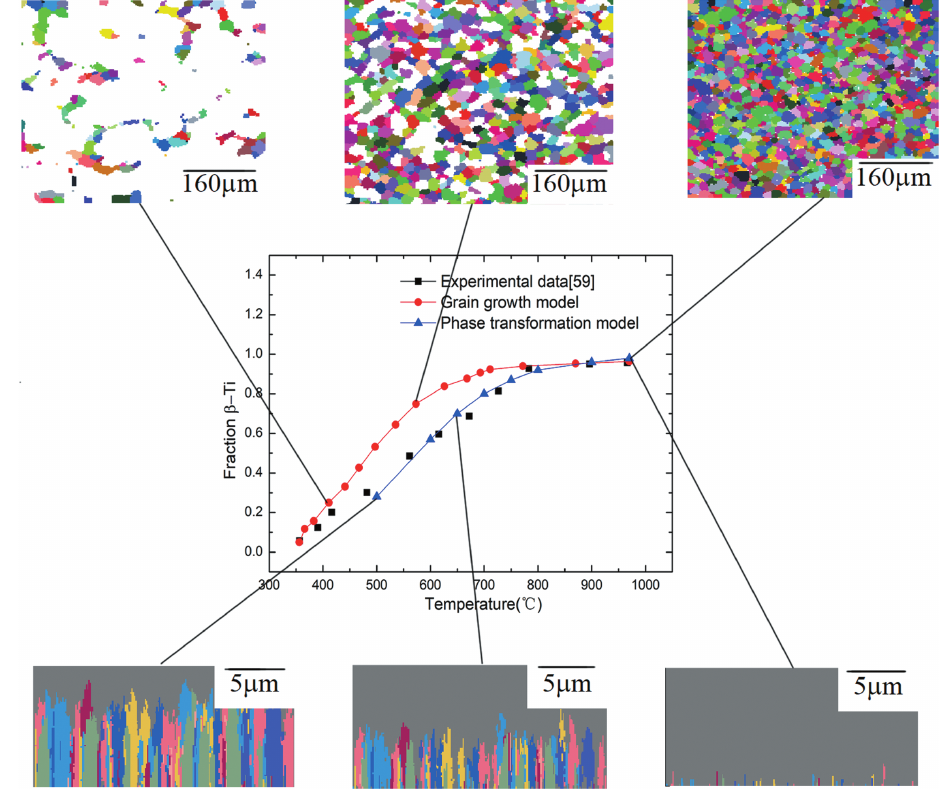
Figure 5: Variation of volume fraction of β in SZ with